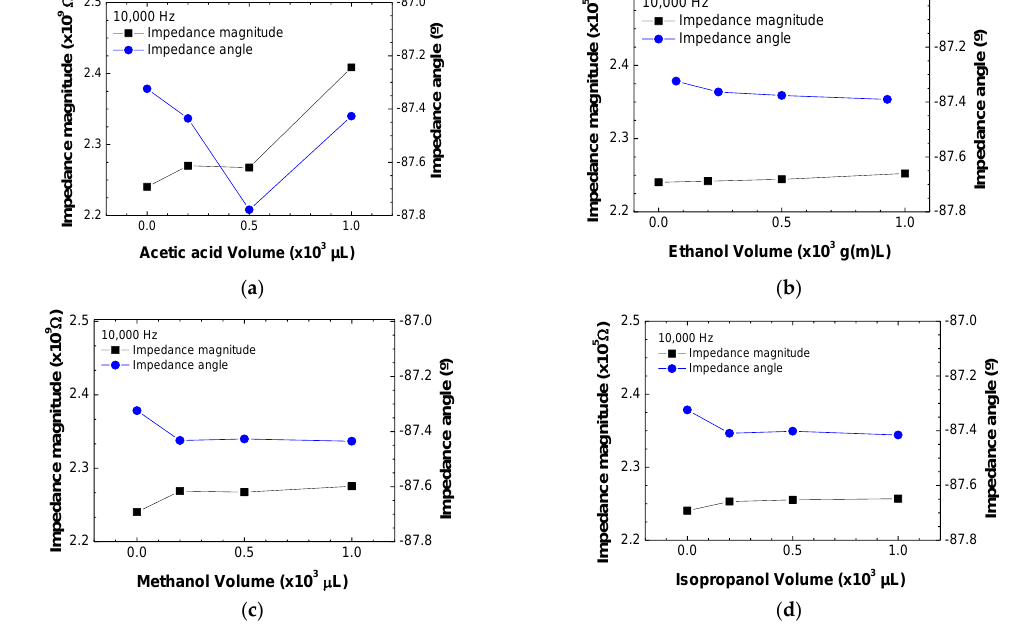
Figure 2. Impedance magnitude and impedance angle at a fixed frequency of 10 4 Hz for different concentrations of acetic acid ( a ), ethanol ( b ), methanol ( c ), and isopropanol ( d ) in air. The lines between the experimental points are